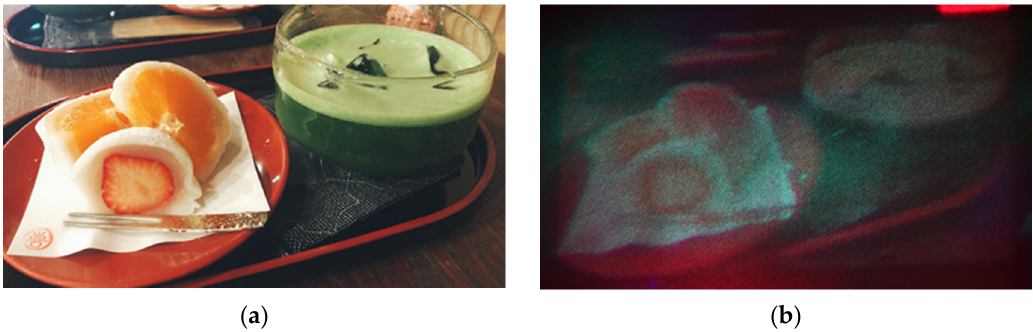
Figure 12. Another colored original image ( a ) and full-color reconstruction ( b ).